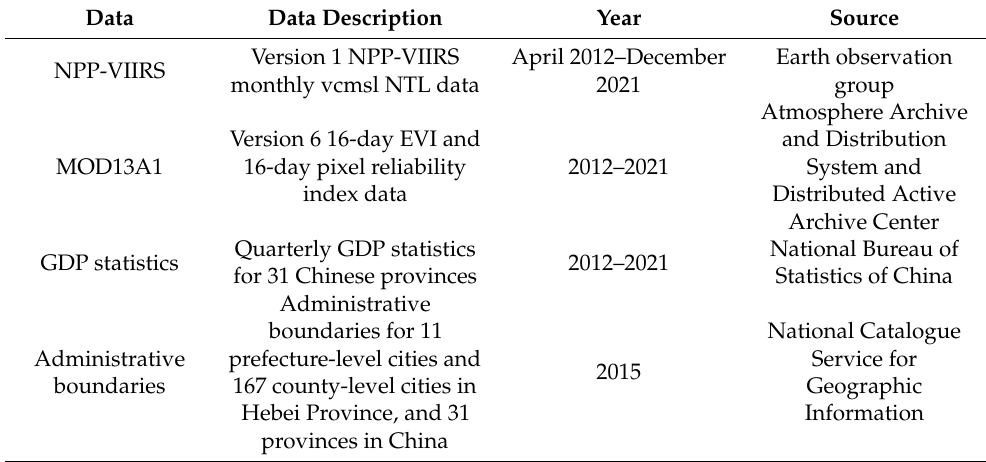
Table 1. Introduction of data sources.